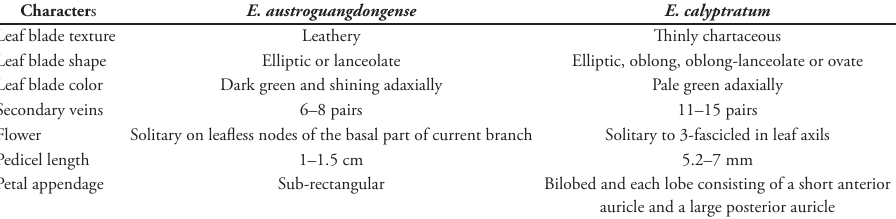
Table 1. Morphological comparison of Erythroxylum austroguangdongense and E. calyptratum . Character